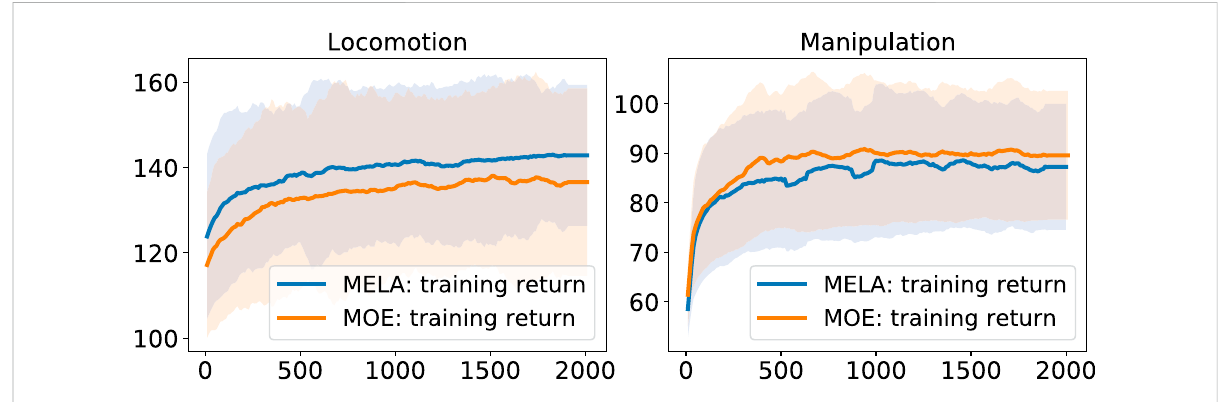
FIGURE 13 Comparison oflearningcurvesofMoE and MELA. The learningcurvesareaveraged over5separatetraining runs and therobot can standwith a reward higher than 100.